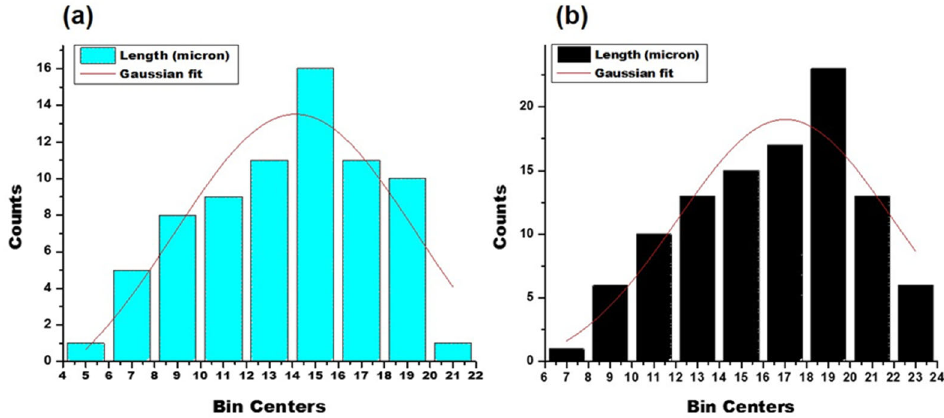
Figure 2. Particle size distribution plots of 5 ‐ FU ‐ loaded SEMC: uncoated ( a ); ERS coated ( b